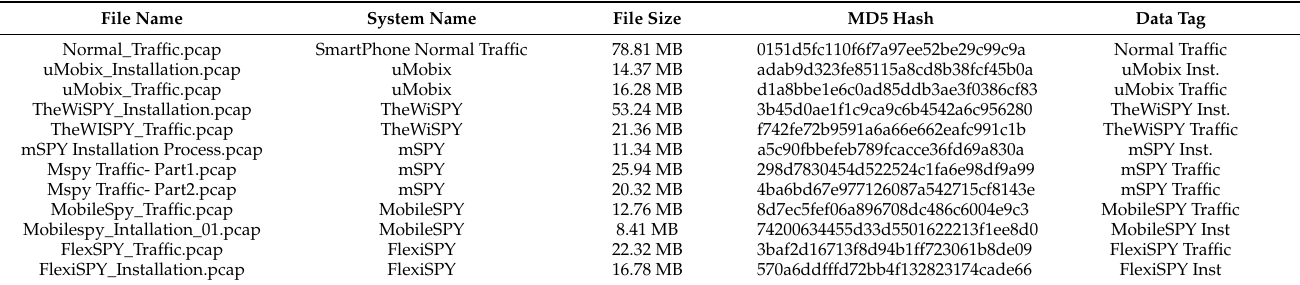
Table 5. Dataset files list and description.